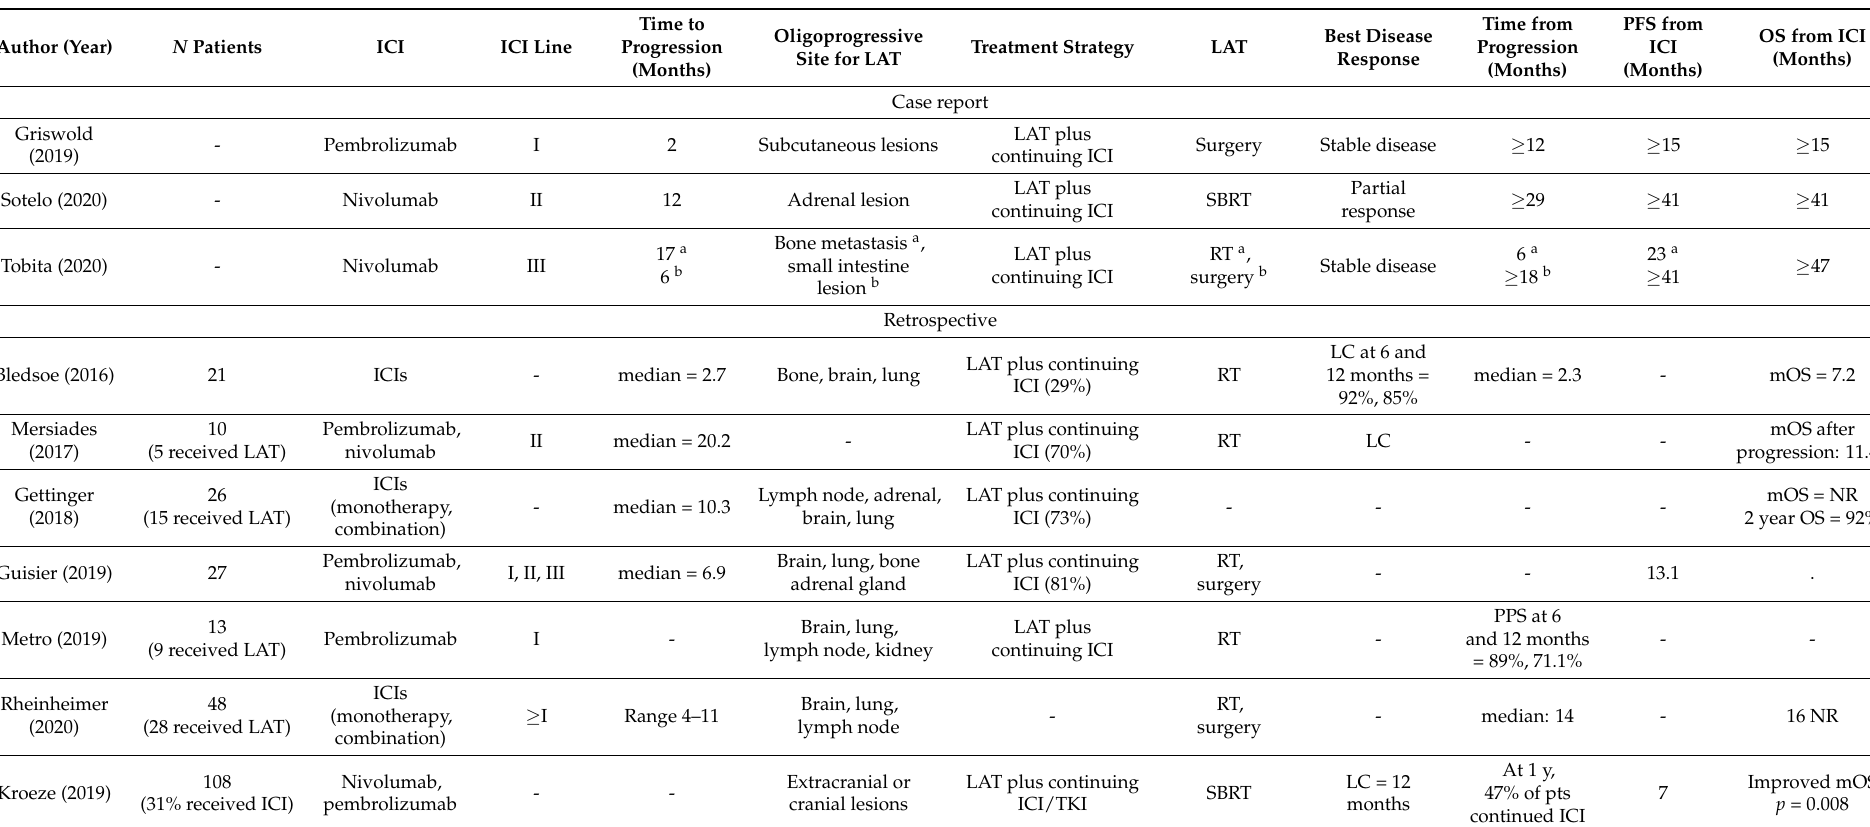
Table 1. Current evidence on local ablative therapy (LAT) in advanced non-small cell lung cancer (aNSCLC) patients who oligoprogressed on immune-checkpoint inhibitors